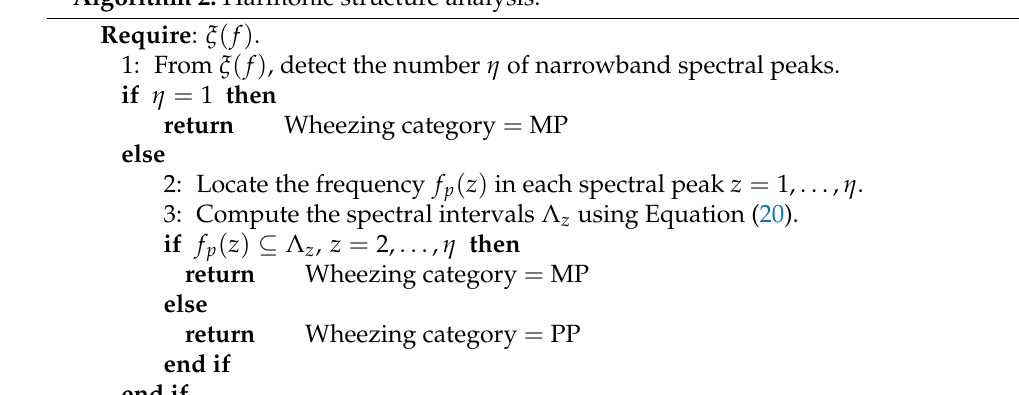
Algorithm 2: Harmonic structure analysis.